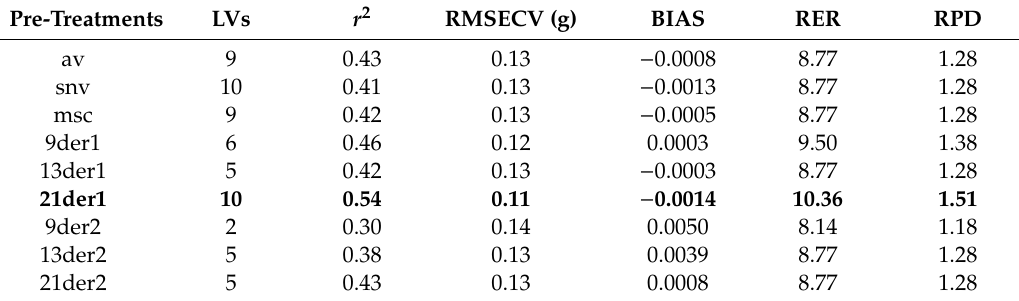
Table 3. Summary of Partial Least Squares Regression (PLS) results for the prediction of firmness (g). The best PLS model is marked in bold (xder1 = first derivative with x number of smoothing points; xder2 = second derivative with x number of smoothing points; av = average; LVs = Latent Variables; RMSECV = Root Mean Square Error of Cross Validation; RER = Range Error Ratio; RPD = Ratio of Performance to Deviation).